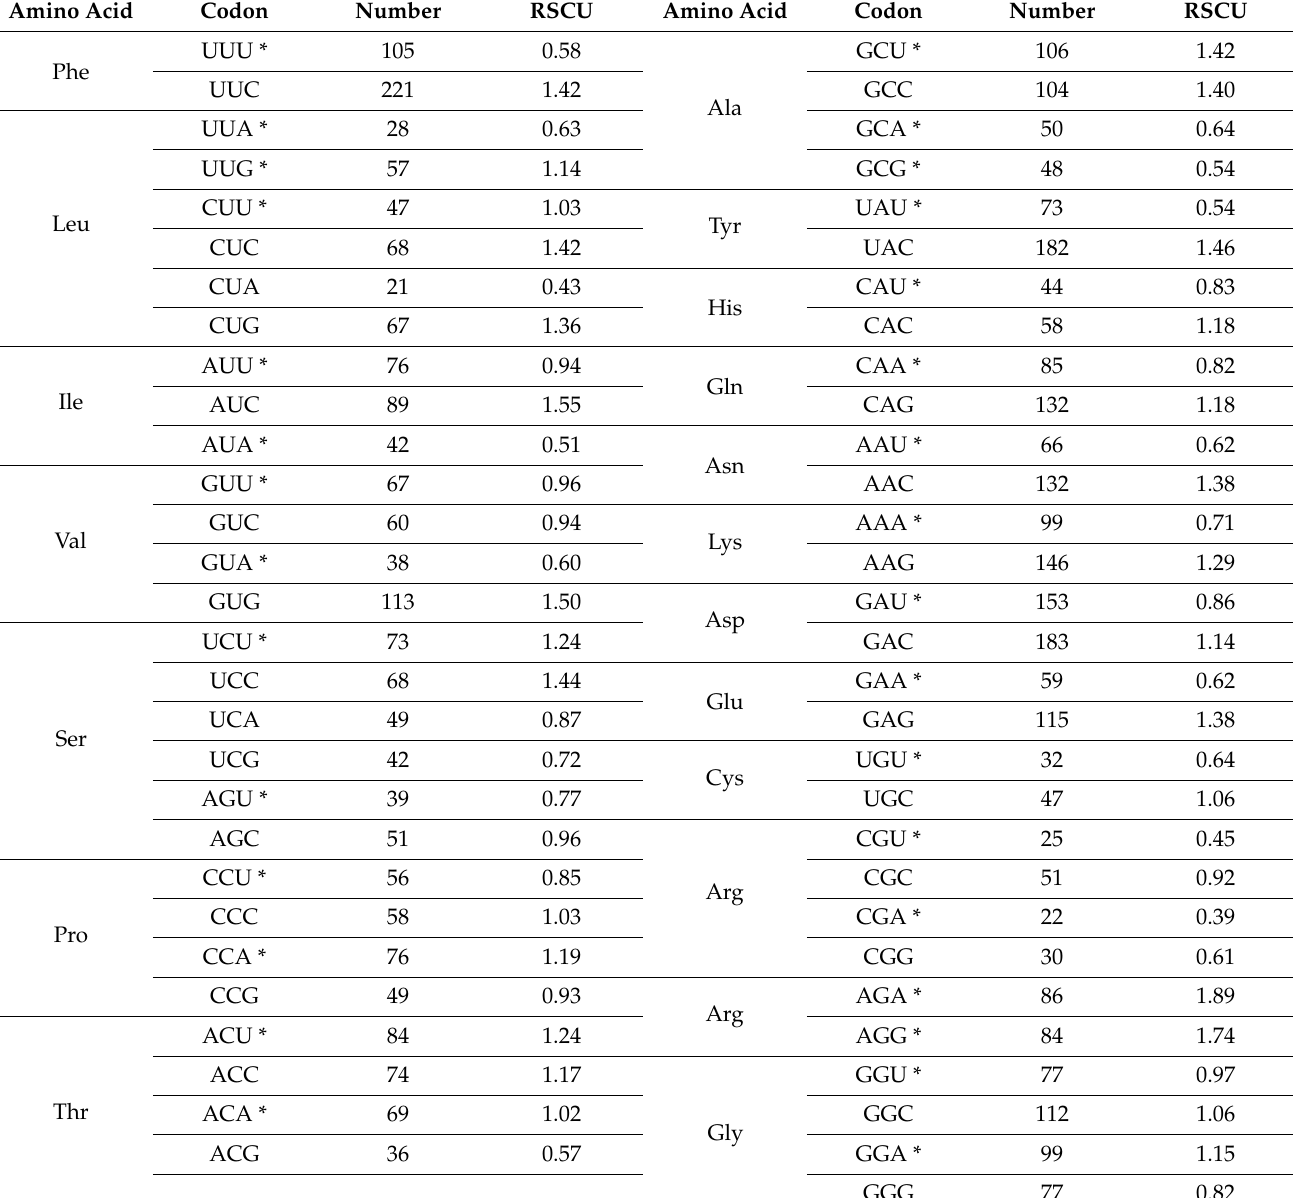
Table 2. Relative synonymous codon usage values and number of codons for the 20 XET genes (4500